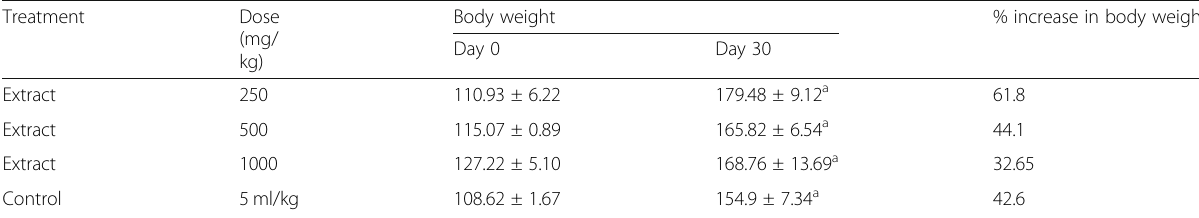
Table 3 Effects of ethanol fruit extract of H. madagascariensis on body weight (Mean ± S.E.M). During the 30 days of study and observation, there was a statistically significant ( P < 0.05) change in the body weight of the rats in all the group Treatment